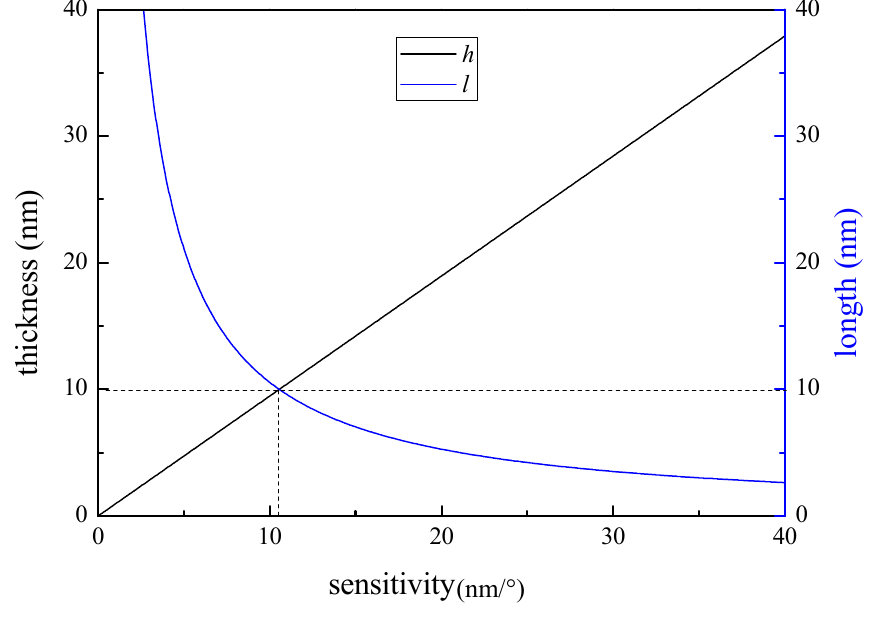
Figure 4. The relationship among S , h and l.